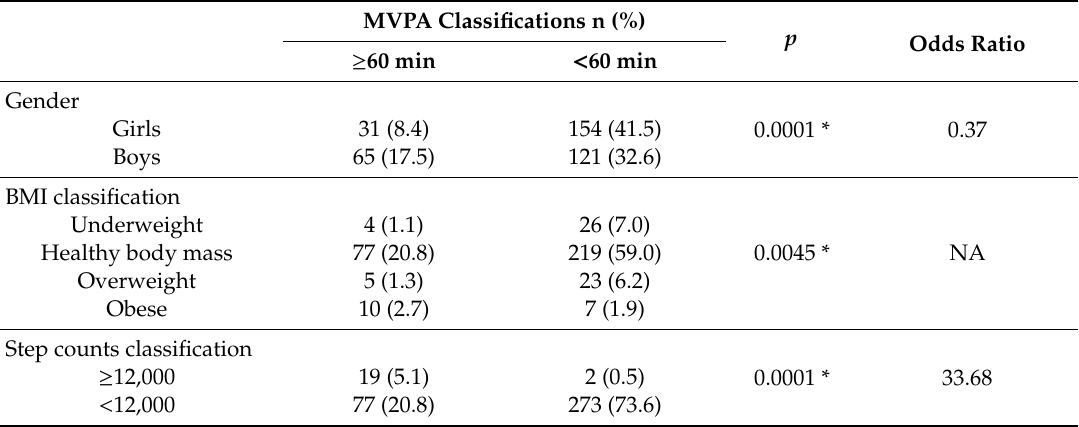
Table 3. Moderate to Vigorous Physical Activity classification.